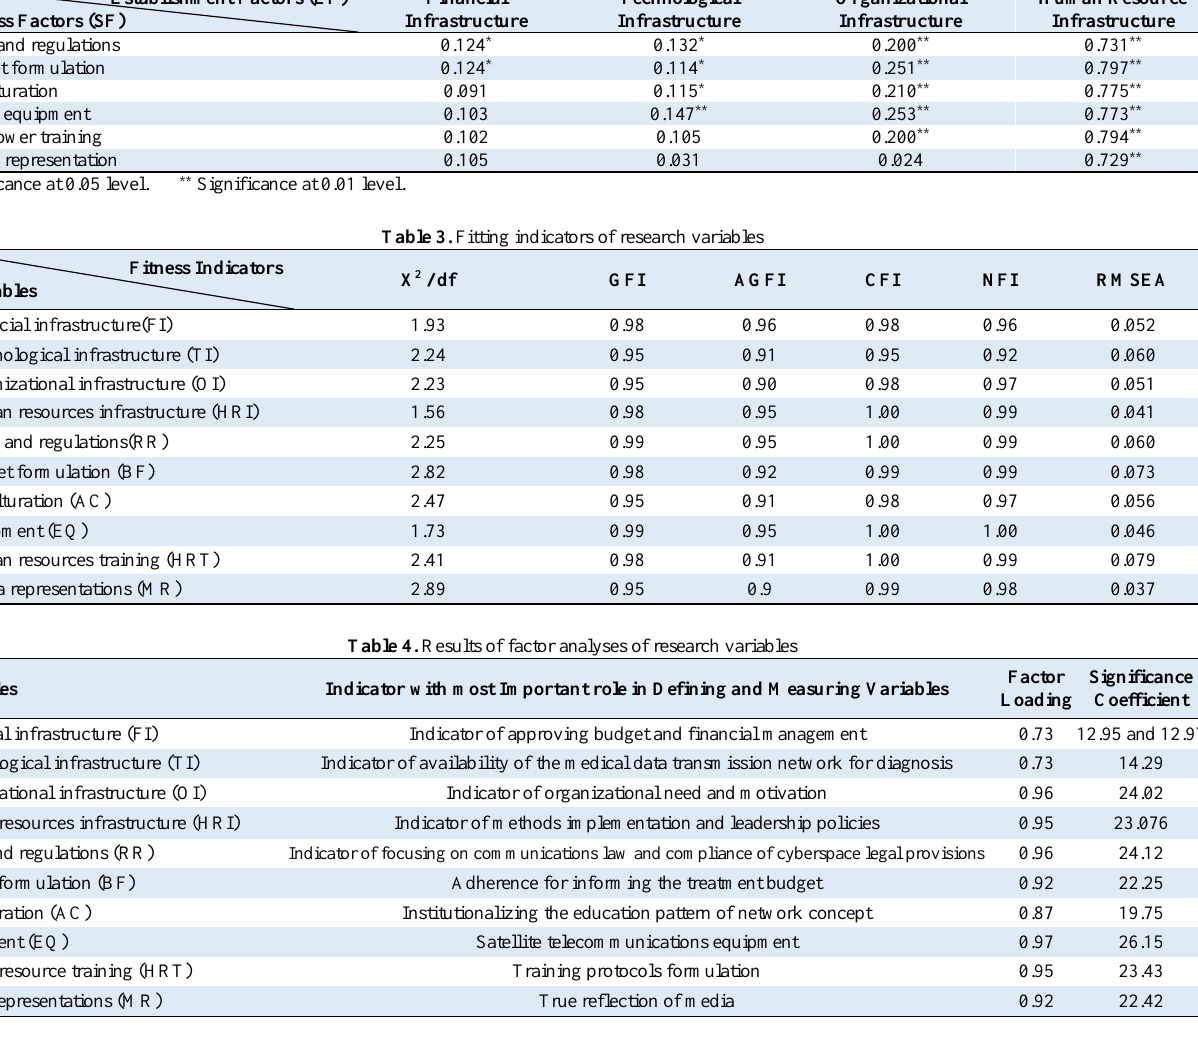
Table 2. The correlation matrix between research variables (sample size = 341) Establishment Factors (EF)